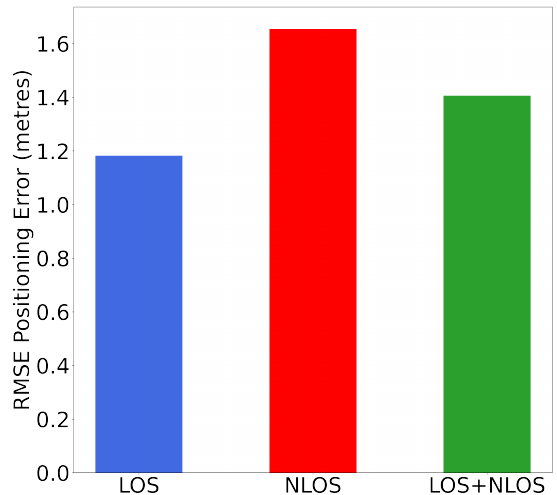
Figure 15. The RMSE result of indoor positioning WiFi signal measures from only LOS APs, NLOS APs, and all the APs. Please note that all statistical features from the corresponding APs were leveraged. Using only raw statistical features from LOS APs improved the positioning accuracy by up to 29 % compared to only using NLOS signals.